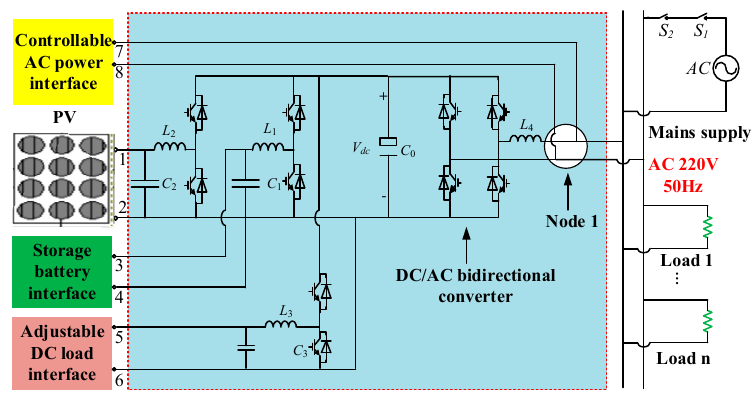
Figure 1. Structure of the single-phase electric energy router (SPEER).